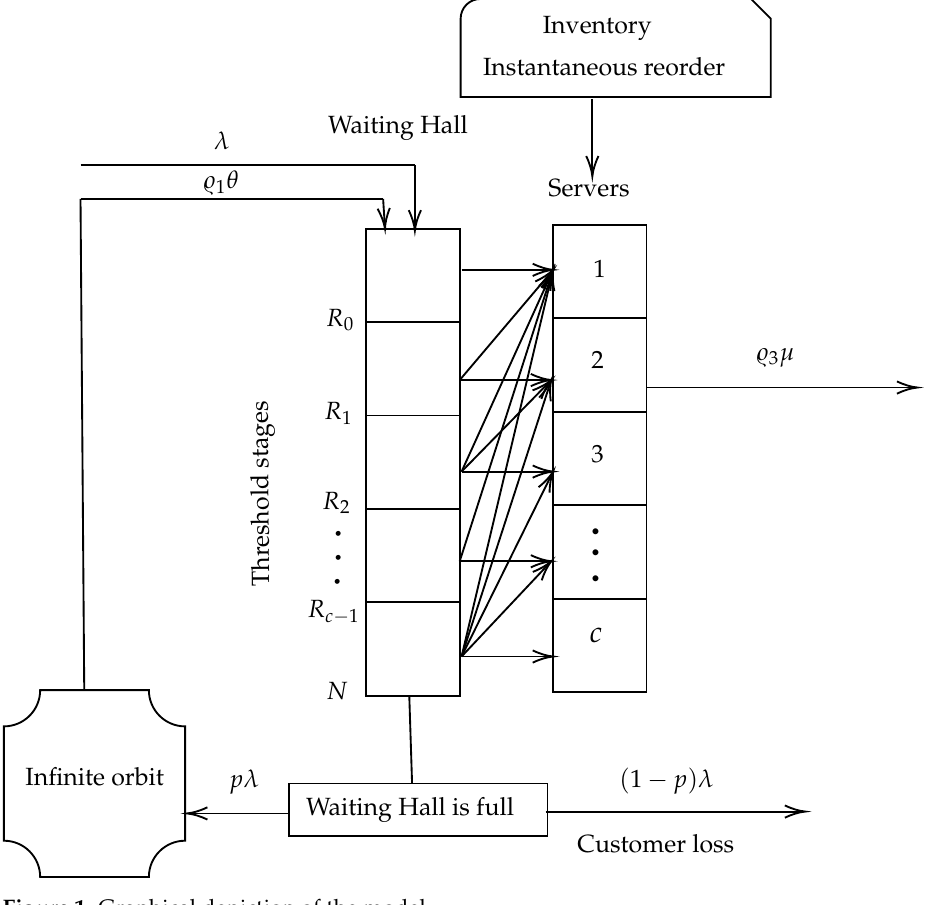
Figure 1. Graphical depiction of the